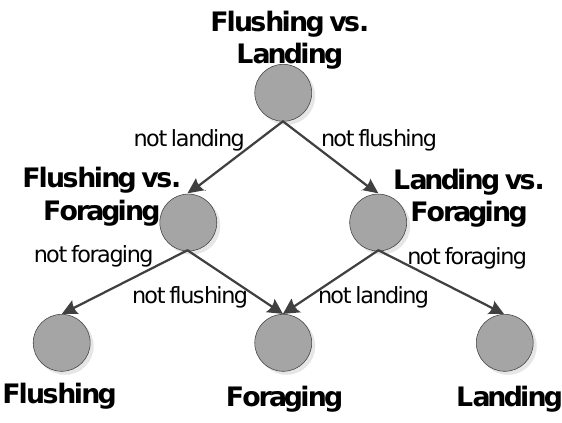
Figure 5. One- versus -one classification in a directional graph, where the direction is based on the SVM model results. The binary classification in each node, will result in classification of a single behaviour.